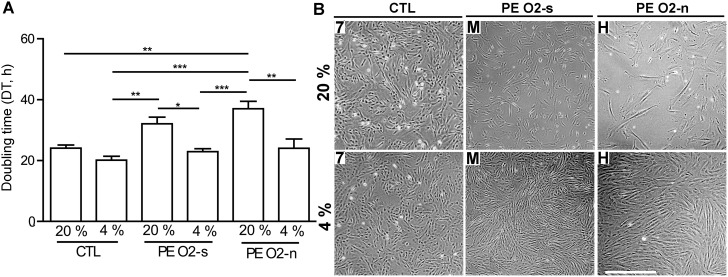
Effect of switching UC fibroblasts from 4% O2 to 20% O2 conditions on cell proliferation.(A) Doubling time of cells after switching to 20% O2. Cell lines were in three groups: CTL (#7, 8, 9, 10), PE O2 sensitive (O2-s; G, I, J, M) that had not formed outgrowths under 20% O2, and PE O2 non-sensitive (O2-n; D, H, L) that had formed outgrowths under 20% O2. For this experiment, p 1 frozen cells established under 4% O2 conditions were thawed and cultured in T-25 flasks under 4% O2. When these p 2 cells were ∼90% confluent, they were transferred to 6-well plates (20,000/well in DMEM-LG medium under either 20% or 4% O2 conditions. Cell numbers were assessed at 24, 48, 72, and 96 h after sub-culture to calculate population doubling times. Values are means ± SEM (CTL, n = 4, PE O2-s, n = 4, PE O2-n, n = 3). The statistical analysis was conducted by ANOVA (*P≤0.05; **P≤0.01, ***P≤0.001). (B) Cell morphologies of selected PE and CTL cell lines after switching the cells from 4% to 20% O2 at p 3 and culturing for a further 5 days (top panels). The controls (lower panels) were continuously maintained under 4% O2 for 5 days. The experiment was identical to that in A, and images shown are of the CTL line #7, PE line M (an O2-s line) and PE line H (an O2-n line). Bar, 0.5 mm. Images of other PE & CTL lines from this experiment are shown in Fig. S1 in File S1. The slower growth under 20% O2 conditions required five days of culture to provide sufficient cells in the field of view to represent a typical population.